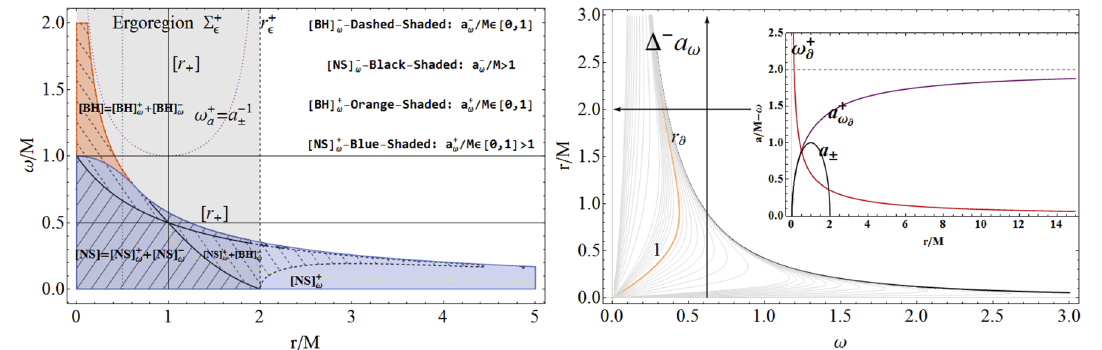
√ r ( r − 2 M ) , are shown. Inside panel: The frequency ω + ∂ , spins a ± = which define the BHs horizons and a + ω defined in Eq. (16) as functions ∂ of r /